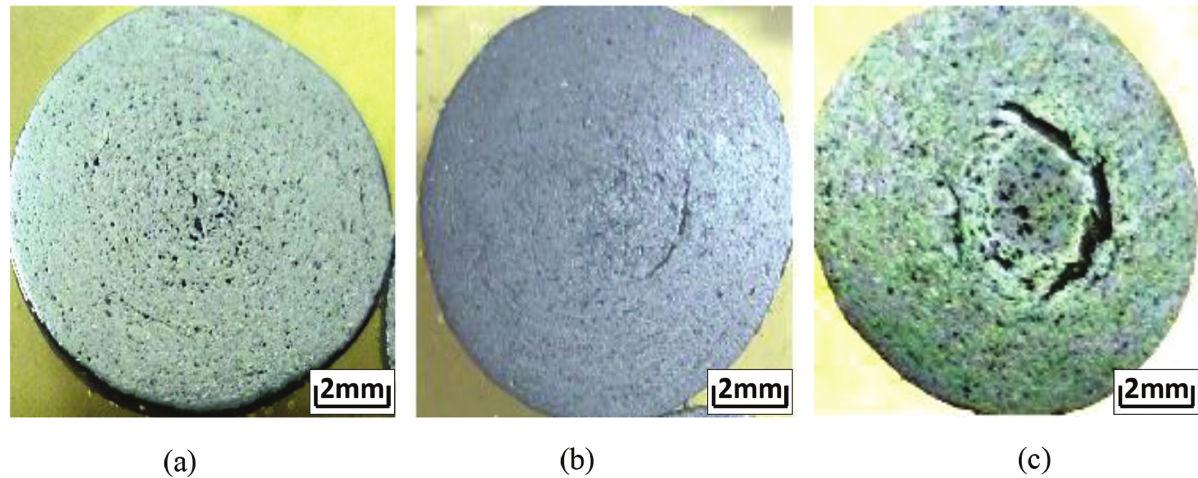
Figure 8: Inner-structures of fired pellets at different coke fines dosage (Preheating at 1,050°C for 15 min and firing at 1,250°C for 15